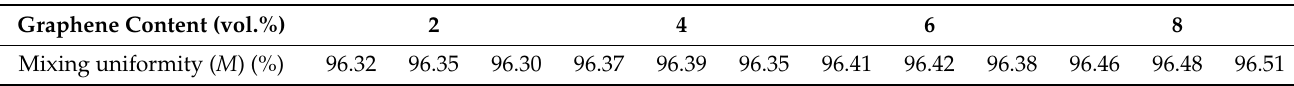
Table 1. Relationship between graphene content and the mixing uniformity of